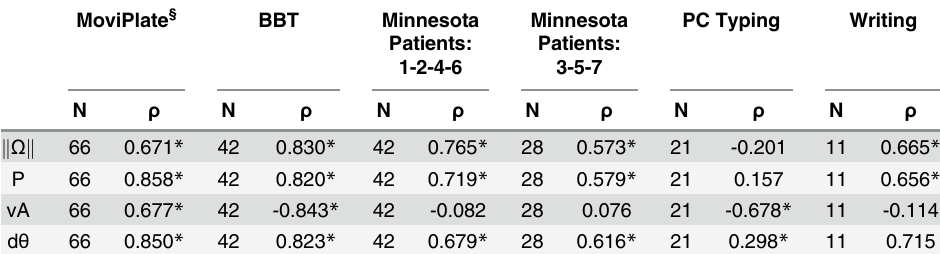
BBT — Box and Block test; N — number of trials for both dominant and non-dominant hands of all the patients at both visits.